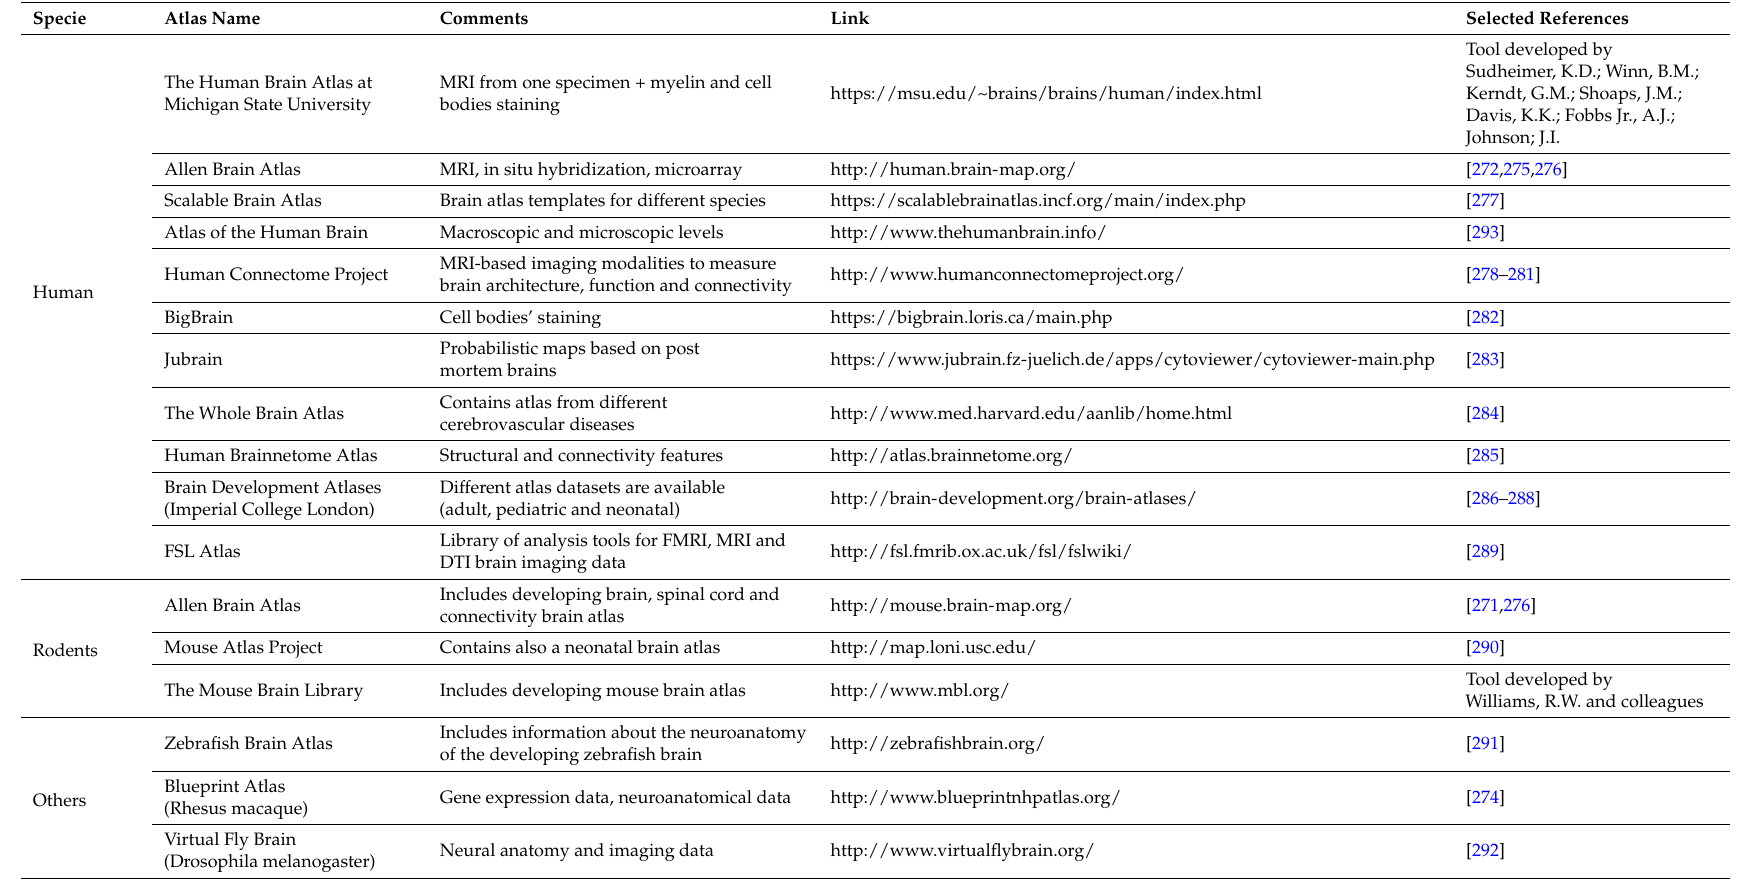
Table 1. Examples of available online brain